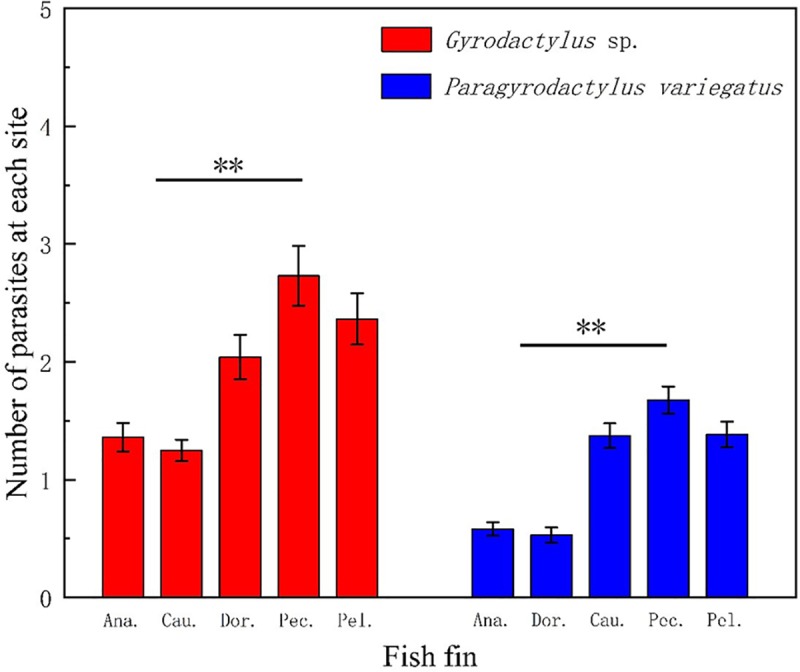
Number of Gyrodactylus sp. and Paragyrodactylus variegatus on different fish fins, the abbreviations Ana., Cau., Dor., Pec., and Pel., indicate, anal fin, caudal fin, dorsal fin, pectoral fin and pelvic fin, respectively.*p < 0.05; **p < 0.01.